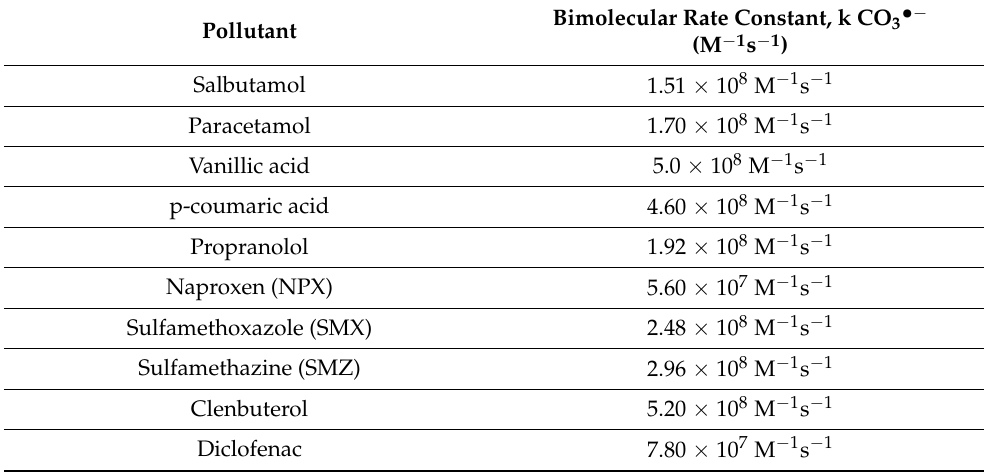
Table 2. The bimolecular rate constants for the reaction of CO 3 •− with some pharmaceuticals [61]. Bimolecular Rate Constant, k CO 3 • Pollutant